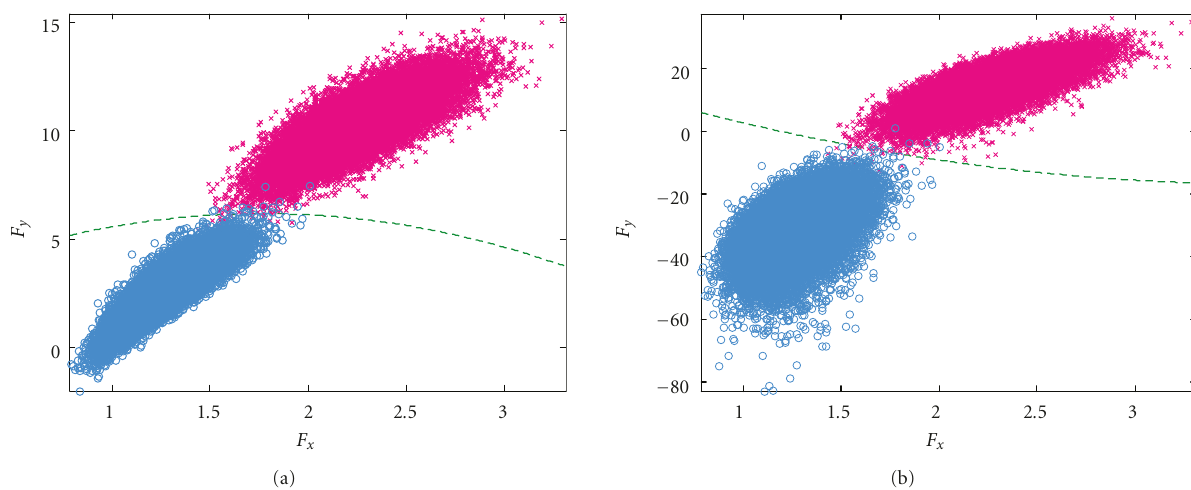
Figure 3: Representative signal distribution in 2-D features plane for (a) ERFC scheme, and (b) OFC scheme. The channel E b /N o is 12.5 dB. Notice that the data points labeled by “ × ” denote the channel state H 1 , while the cycles represent H 0 .